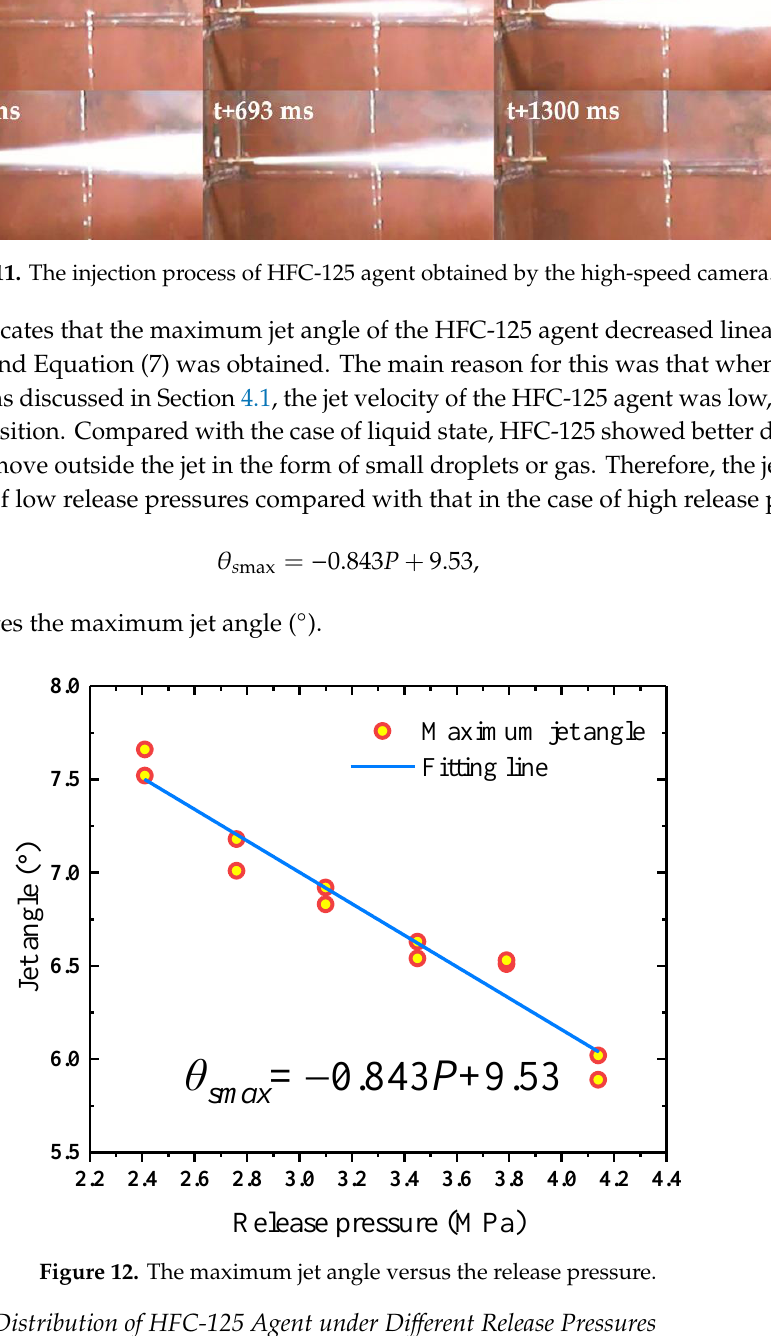
Figure 10. Jet angle.